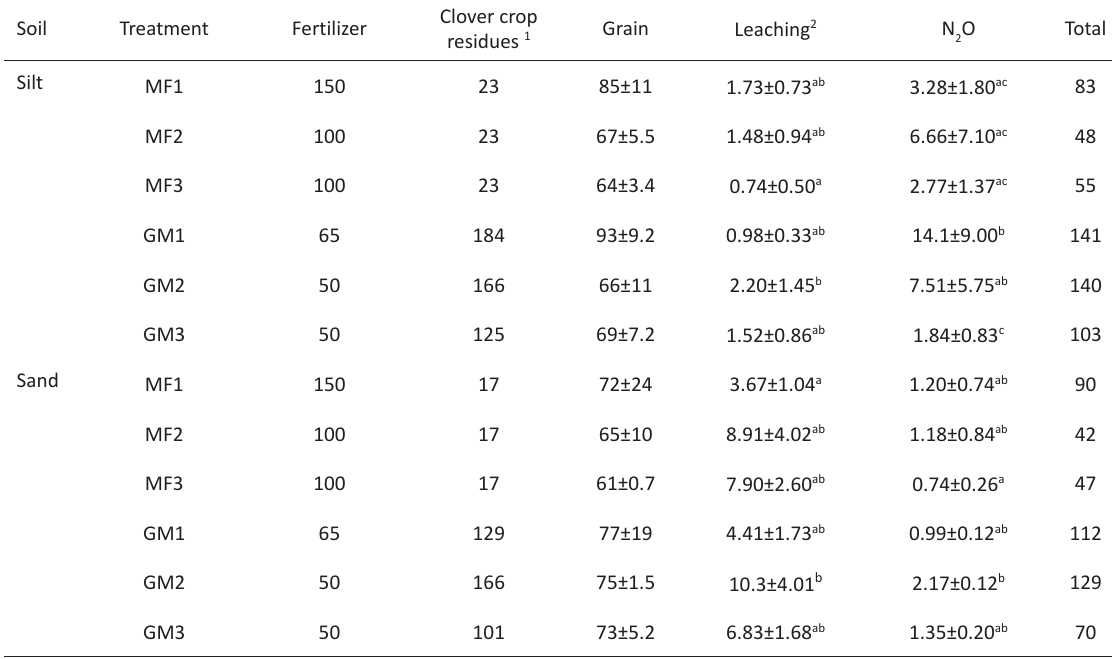
Table 3. Annual N input (fertilizer + clover residues) and output (grain + leaching) (±standard deviation) and their sum (kg ha -1 ) in